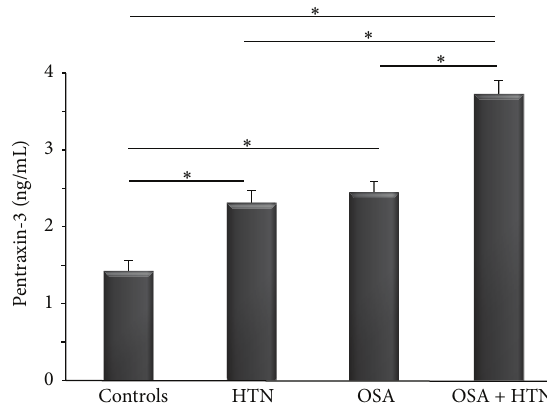
Figure 3: PTX-3 in controls, HTN, OSA, and OSA + HTN subjects. ∗ 𝑝 < 0.01 .